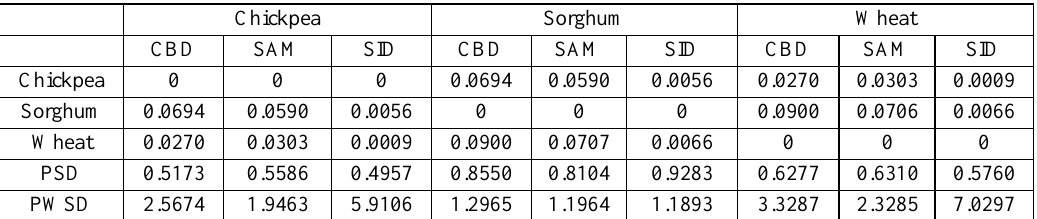
Table 7: Spectral similarity and discriminatory values: Spectra developed conventionally Chickpea Sorghum Wheat